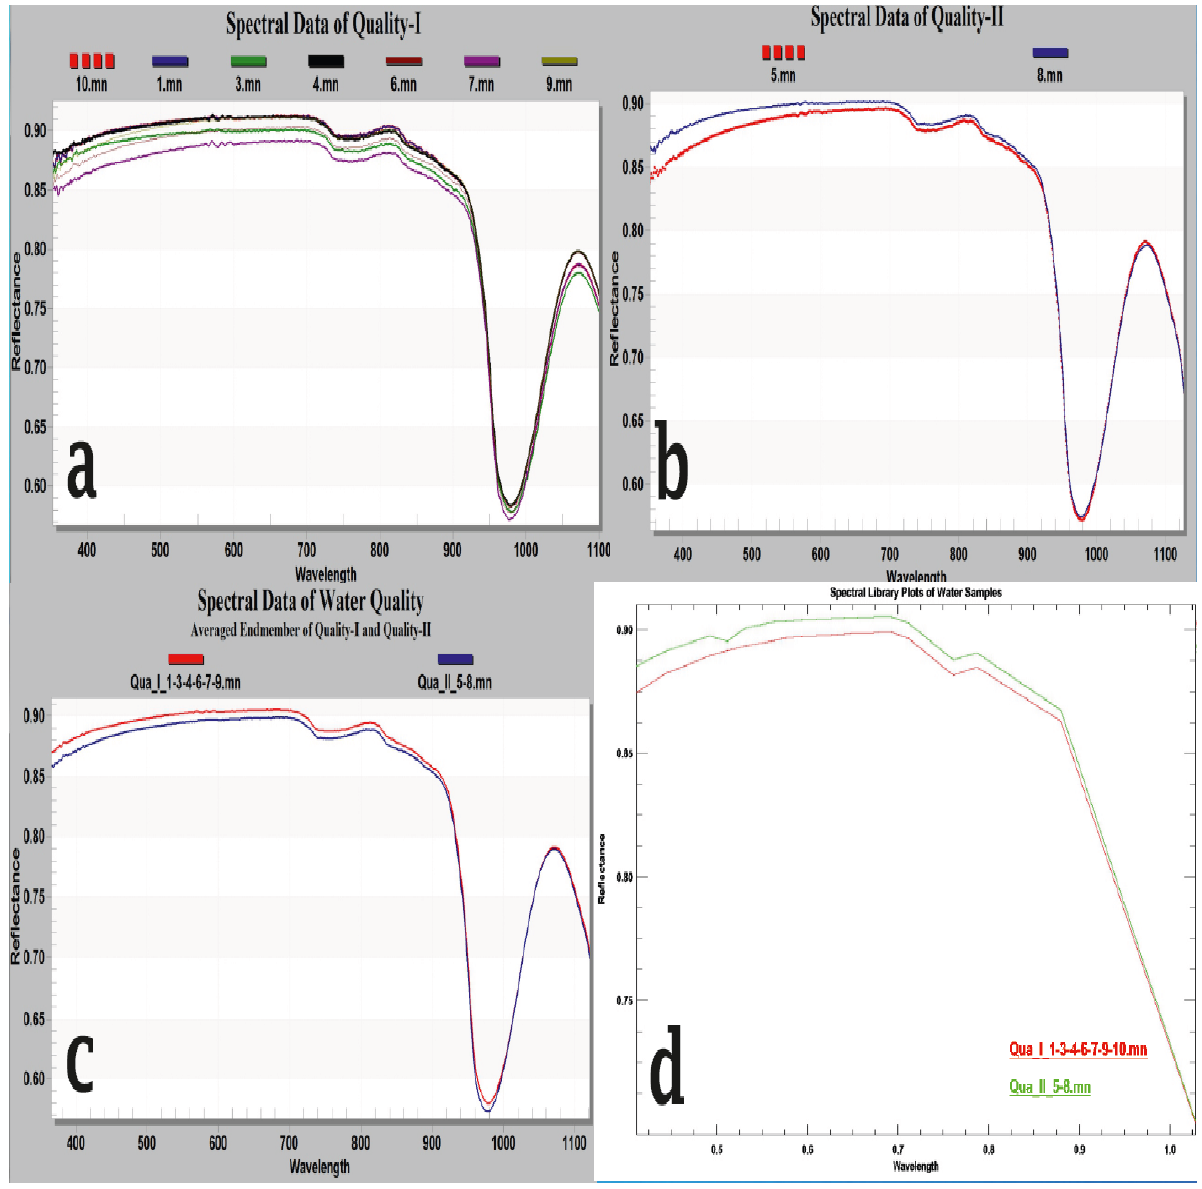
Figure 4. a) Spectral data of Water Quality I, b) Spectral data of Water Quality II, c) Spectral data of both Water Qualities d) Spectral library plot of the both Water